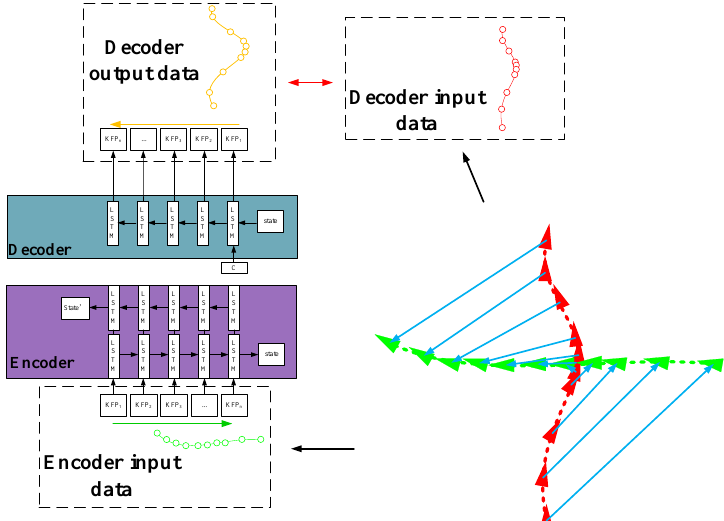
Figure 16. Encoder – decoder structured learning model. Figure 16. Encoder–decoder structured learning Figure 16. Encoder–decoder structured learning model.